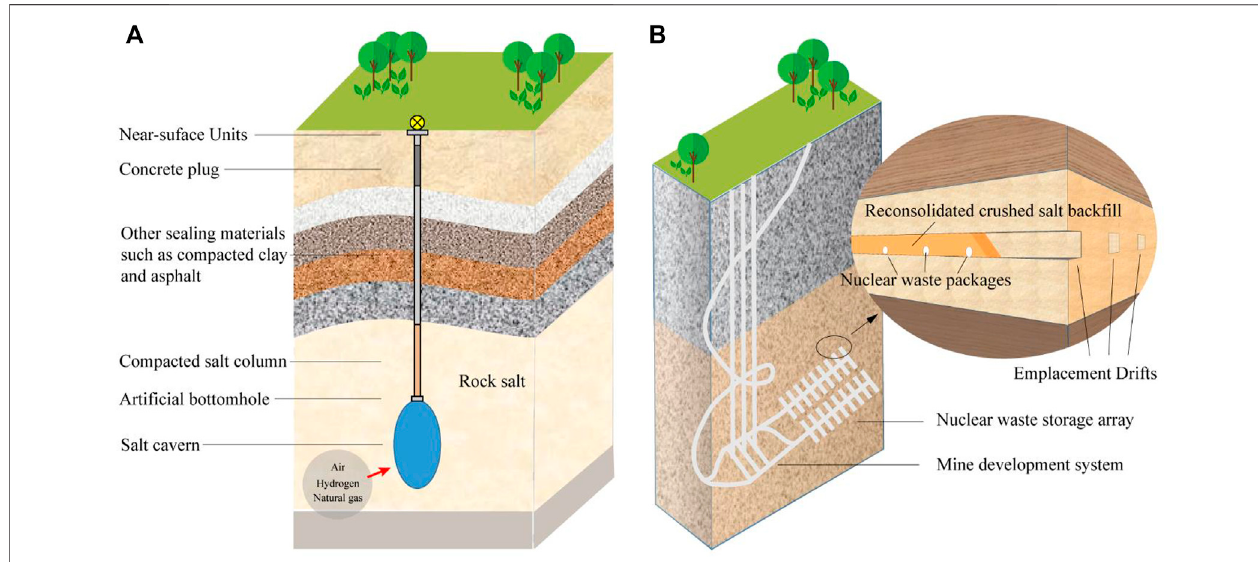
FIGURE 1 | Schematic diagram of underground engineering facilities in salt rock (Kang et al., 2021). (A) Salt cavern is used to store natural gas, compressed air, hydrogen, etc.; (B) Schematic diagram of underground salt rock high-level nuclear waste repository and reconsolidated crushed salt as back fi ll material.